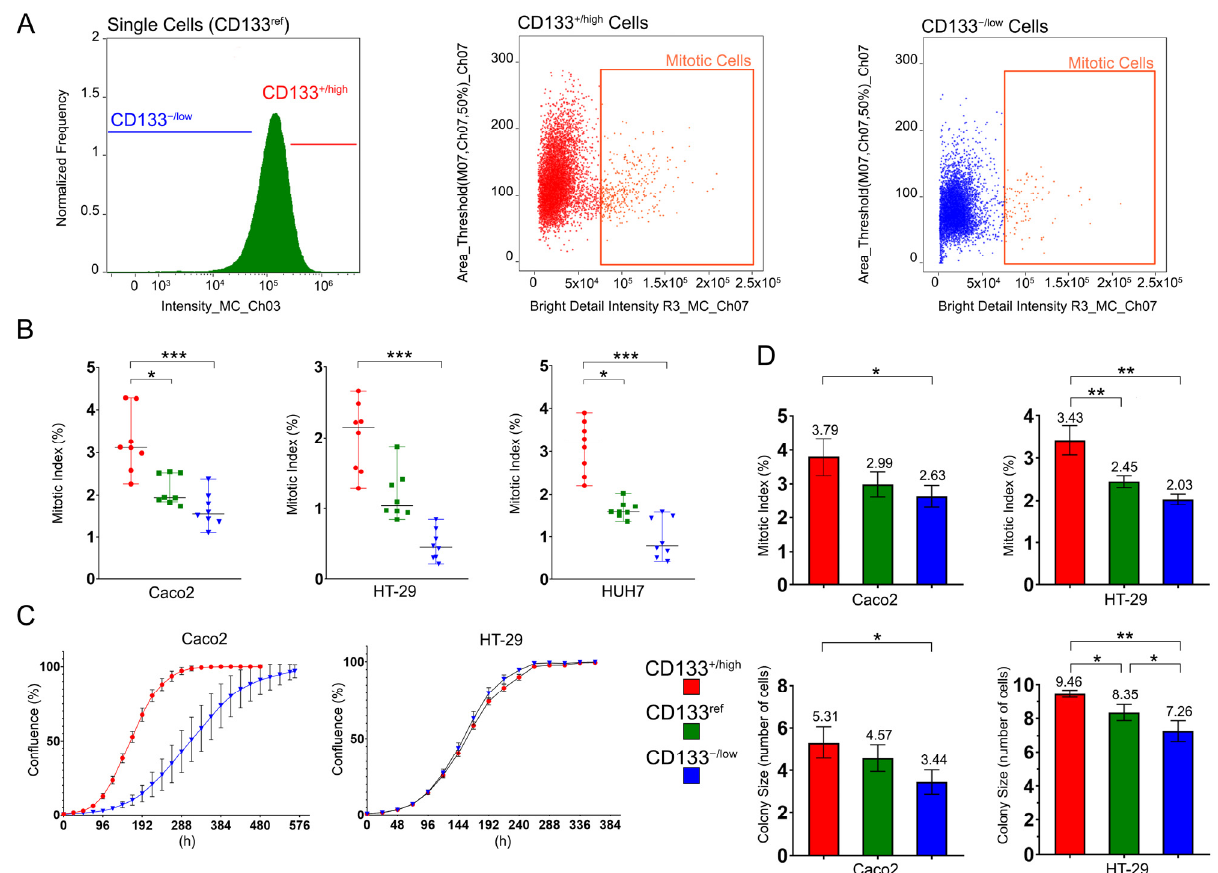
Figure 2. Proliferative activity of cells with different CD133 expression levels. ( A ) Adapted «Im- ageStream» algorithm of mitotic index (MI) counting in populations with different level of CD133 expression. CD133 +/high (red dots) and CD133 − /low (blue dots) populations are defined as cells gated at the upper and lower 10% of fluorescence intensities. CD133 ref denotes the original population encompassing CD133 +/high and CD133 − /low cells. ( B ) MI of populations with different CD133 expres- sion level ( n = 8 for each cell line; median and range). CD133 +/high – red circles, CD133 − /low – blue triangles and CD133 ref – green squares. ( C ) Growth curves of populations with different CD133 ex- pression levels (Caco2 n = 6, HT-29 n = 5; mean ± SD). ( D ) MI (top panel row) and the number of cells (bottom panel row) in three-day colonies formed by CD133 +/high (red columns), CD133 − /low (blue columns), and CD133 ref (green columns) populations. * p ≤ 0.05; ** p ≤ 0.01; *** p ≤ 0.001.